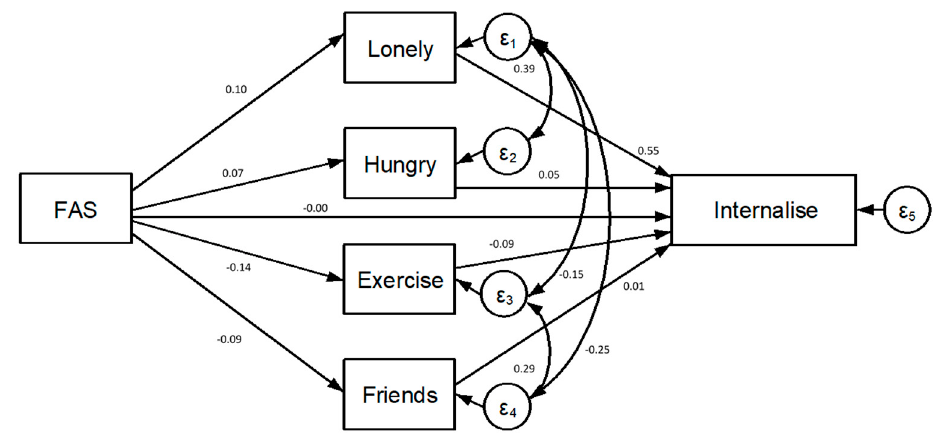
Figure 2. Model 2, which focused on internalising symptoms.